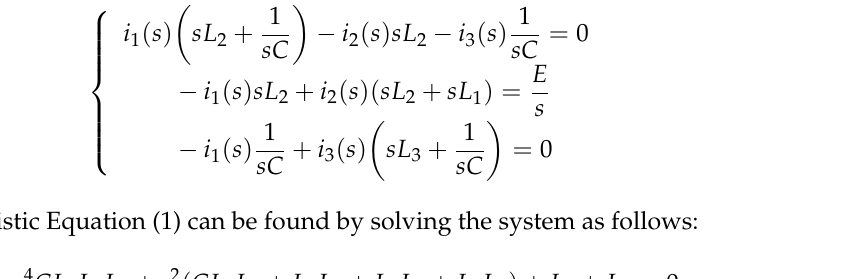
Figure 5. Charge transient circuital lumped model.